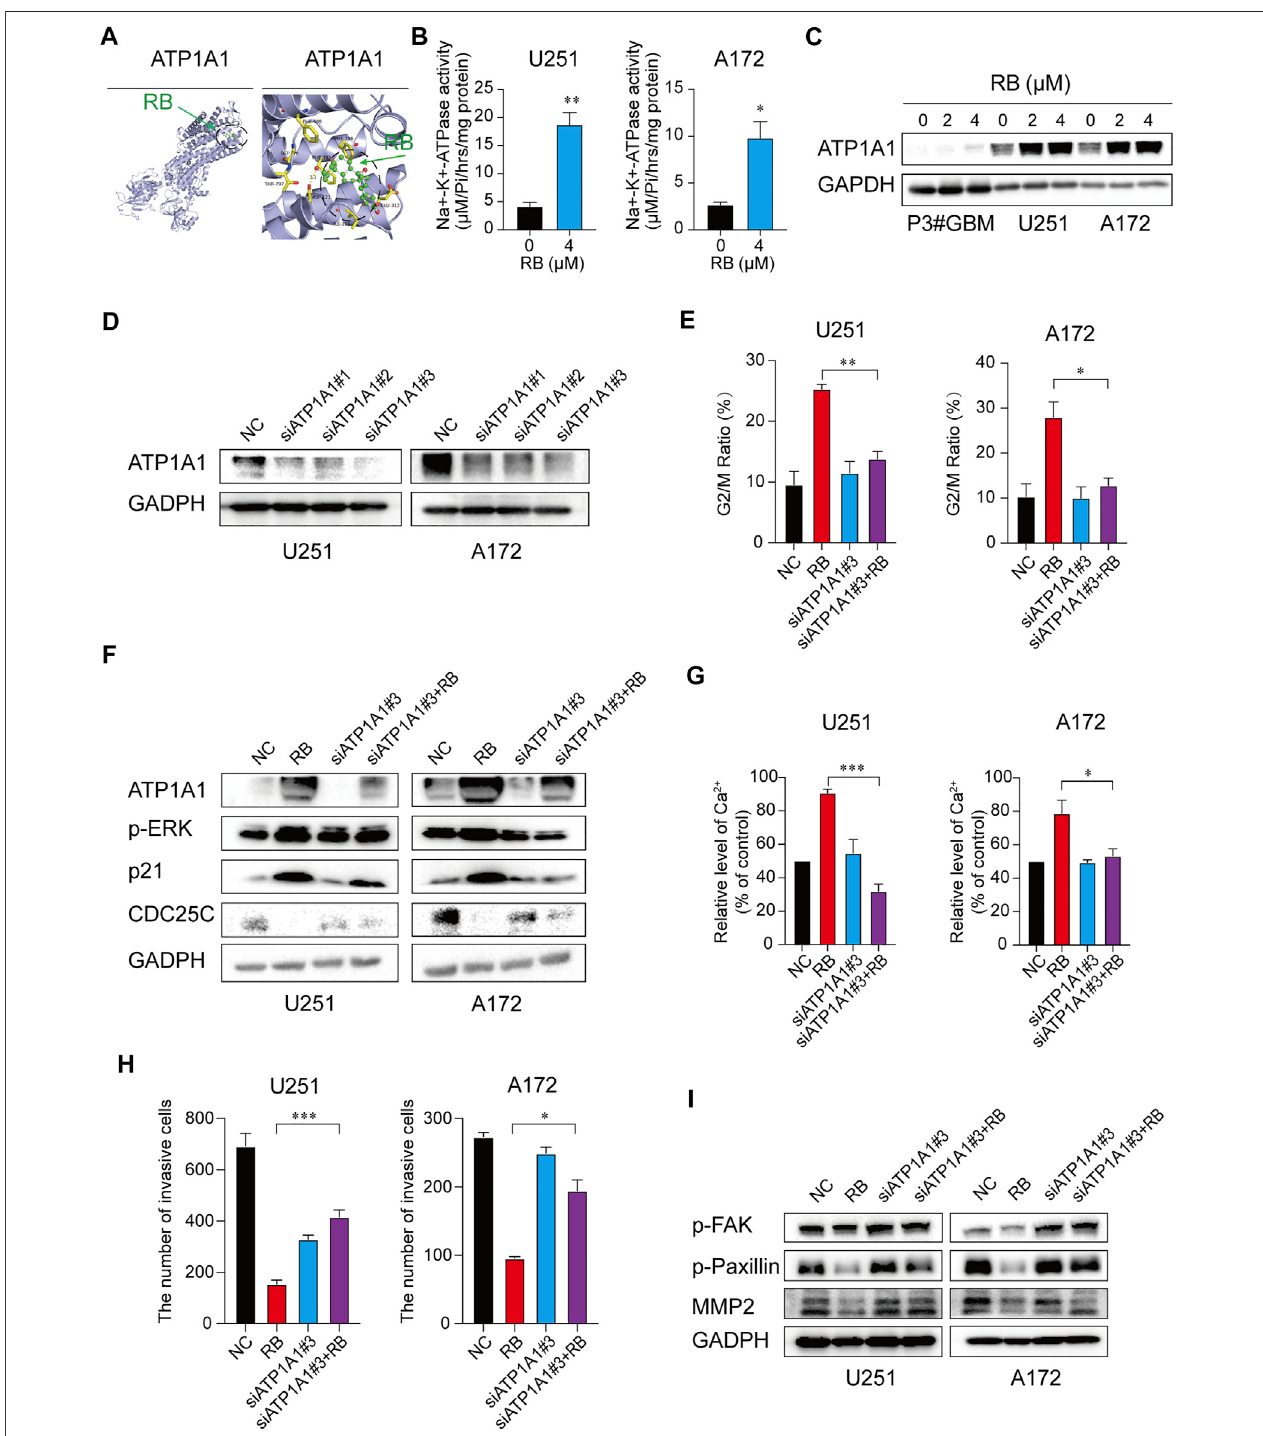
FIGURE 5 | RB inhibits malignant progression of GBM by targeting ATP1A1 and increasing Na + -K + -ATPase activity in GBM cells. (A) The most likely predicted target of RB. The binding energy of RB with the ATP1A1 protein was − 8.7 kcal/mol, proving a good binding interaction. RB interacts with the ATP1A1 protein mainly through the formation of hydrogen bonds as well as hydrophobic interactions. The hydrogen bond length with ASP-121 was 3.1 Å; hydrophobic interactions were formed with Ile-315, Glu-312, Phe-785, Phe-783, Phe-909, Gly-796, and Thr-797. (B) Graphic representation of Na + -K + -ATPase activity. (C) Representative western blot analysis of total ATP1A1 protein expression. (D) Western blotting analysis validated the ef fi ciency of siATP1A1s in GBM cells. (E) GBM cells were transfectedwithsiATP1A1#3for48 handincubatedwith4 μ MRBfor48